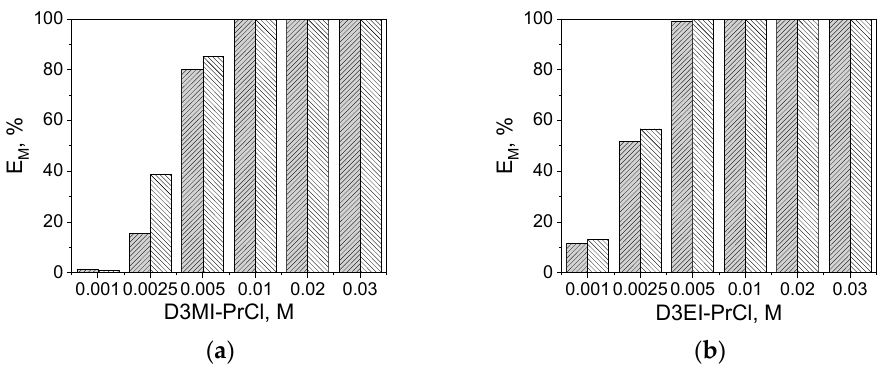
Figure 2. Extraction efficiency of Pd(II) (\\\) or Pt(IV) (///) with ( a ) 5 × 10 − 3 M D3MI-PrCl and ( b ) 5 × 10 − 3 M D3EI-PrCl from feeds containing 2.5 × 10 − 3 M Pd(II) or Pt(IV) in 1 M HCl (A/O = 1). Table 6. Values of distribution ratios of Pd(II) or Pt(IV) with 5 × 10 − 3 M D3MI-PrCl or D3EI-PrCl from feeds containing 2.5 × 10 − 3 M Pd(II) or Pt(IV) in 1 M HCl (A/O = 1). Extractant Concentration in the Organic Phase,